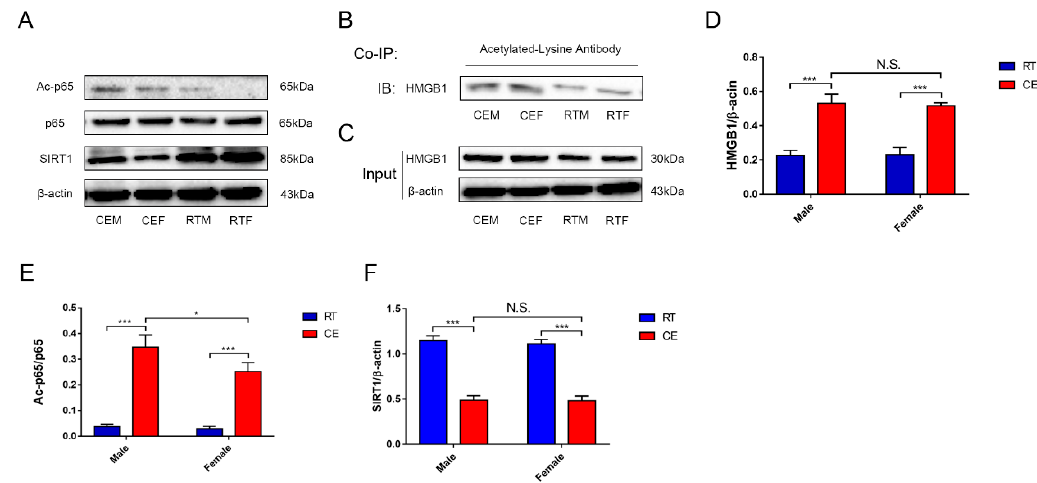
Figure 8. Expression of intracellular signaling pathway components in the hippocampus of cold-stressed mice. ( A ) Acetyl-p65 (Lys310), p65, silent mating type information regulation 2 homolog